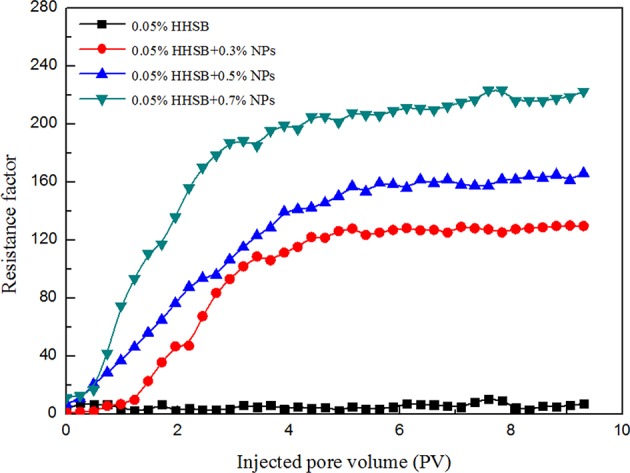
The steady-state resistance factors of SC-CO2 foam in the core flooding as a function of injected pore volume at 70°C and 8 Mpa.